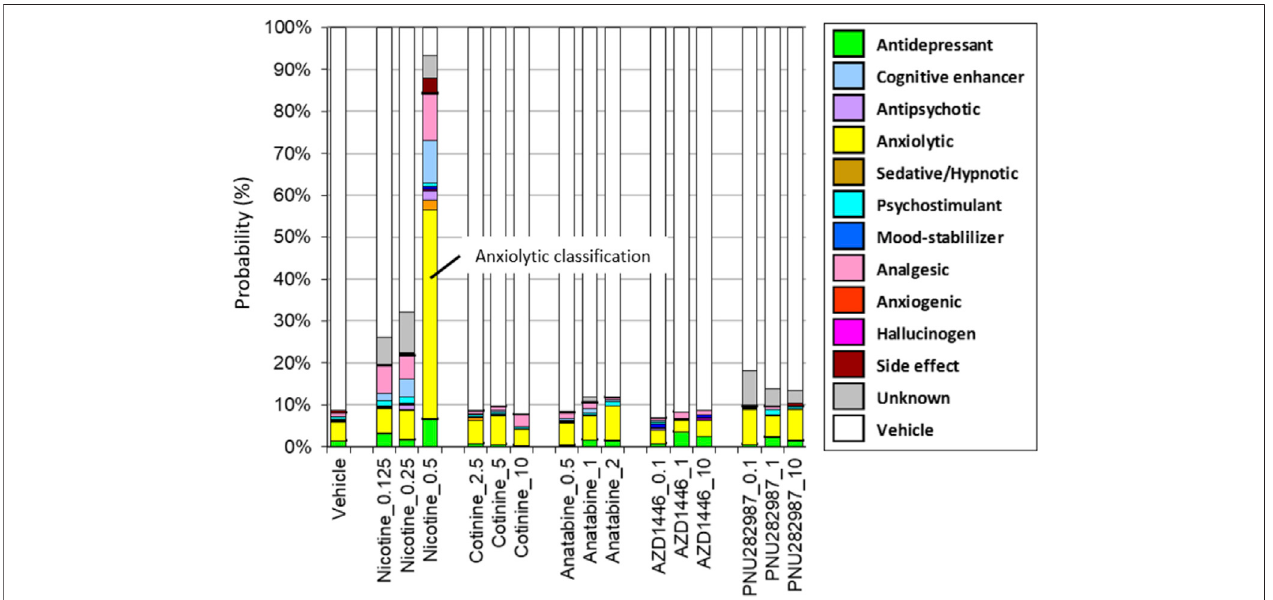
FIGURE 1 | Drug classi fi cations of the plant alkaloids. The drug classi fi cations of nicotine, cotinine, anatabine, and nAChR reference compounds (AZD1446 and PNU282987) determined byusing theSmartCube ® system in mice are presented. Only nicotine induced anxiolytic-likebehavioralsignature(yellow bar). Neither the free base nor citrate form of anatabine showed any changes in behavior. Thus, only the free base data are shown for anatabine. The doses are indicated on the x -axis as mg/kg. The color code is described in the fi gure legend on the left. N = 12 mice.